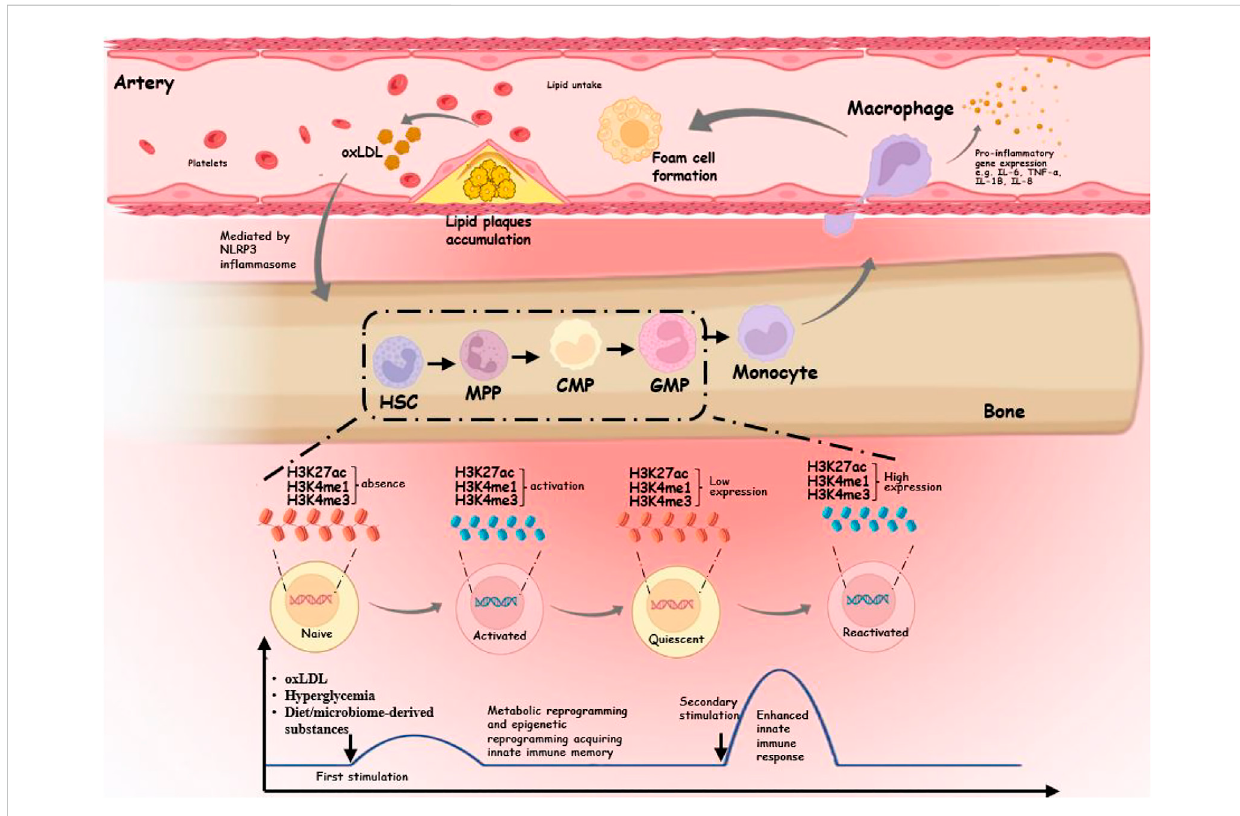
FIGURE 1 Schematic diagram of the trained immunity mechanism in atherosclerotic cardiovascular disease. In the hematopoietic system, myeloid cells exposed to endogenous triggers undergo epigenetic and metabolic reprogramming, resulting in acquiring innate immune memory. The initial gene activation is accompanied by the accumulation of H3K4me3 on the gene promoter, and the persistence of H3K4me1 or H3K27ac in secondary stimulation leads to an enhanced innate immune response. These trained myeloid cells differentiate into monocytes, which travel further into the intimatobecomemacrophages.Trainedmacrophagesproducehighlevelsofproin fl ammatorycytokinessuchasTNF- α ,IL-6,IL-8,andIL-18anduptake of lipids to form foam cells. When plaques form, endogenous stimuli may be further released to form trained immunity mediated by the NLRP3 in fl